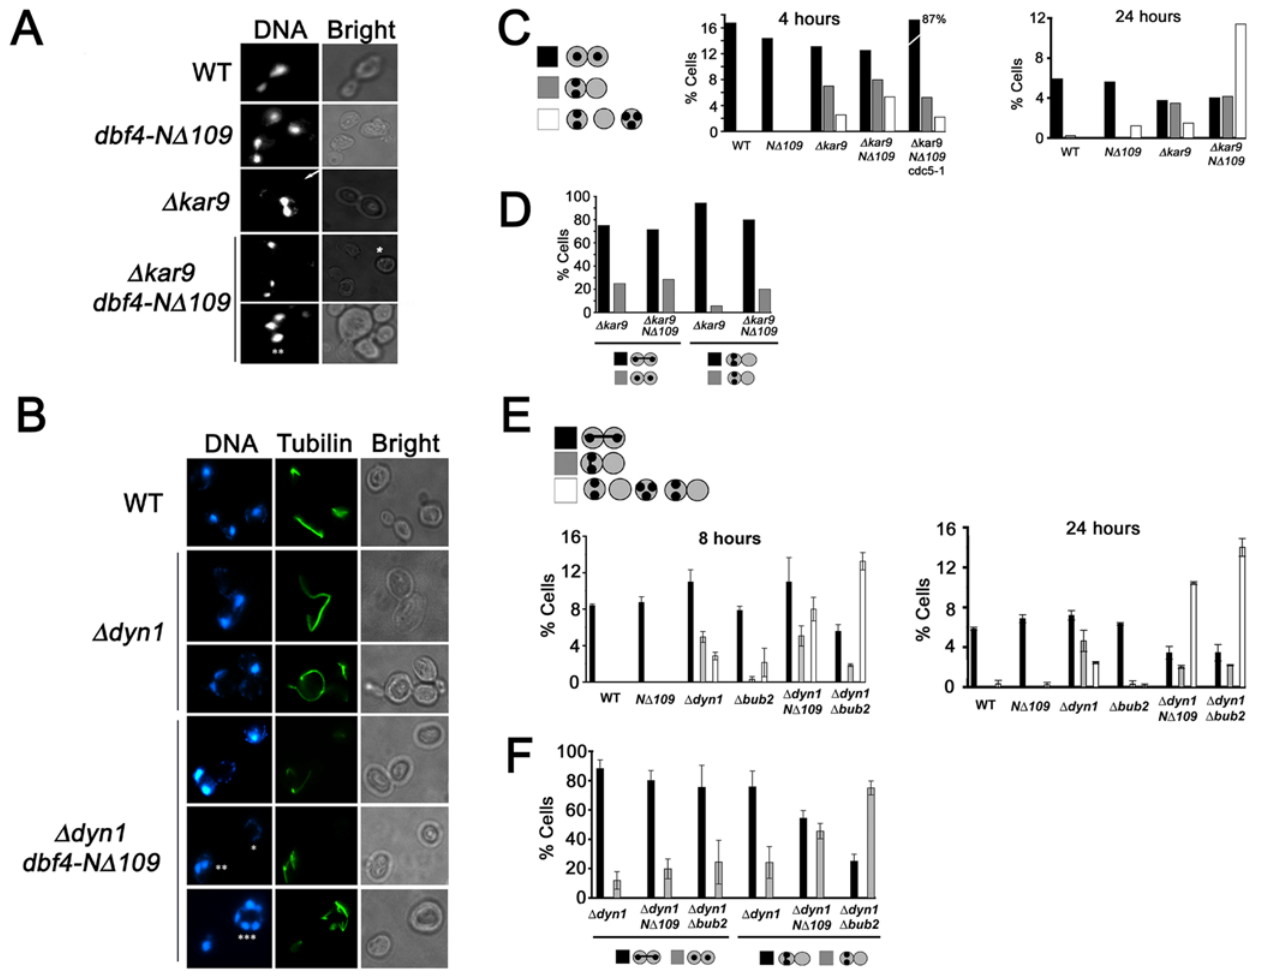
Figure 7. Deletion of the DBF4 PIR allows exit from mitosis in cells with misoriented nuclei. (A, B) Representative cells showing nuclear positioning and mitotic arrest defects. Nuclear position was analyzed after DAPI staining. Cells with anaphase spindles located exclusively in the mother cell body are noted (white arrow). Anucleate (*), binucleate (**) and multinucleate (***) cells were frequently observed in kar9 D dbf4-N D 109 (A) and dyn1 D dbf4-N D 109 (B) cells. (C, E) Quantitation of nuclear segregation defects. . 300 cells were counted for each strain and nuclear position was represented as a percentage of the total cells in culture. Black bars represent cells with nuclei segregated between mother and daughter cells; gray bars, divided nuclei in the mother cell; white bars, multinucleate and anucleate cells. (D, F) Spindle morphology of strains with misoriented nuclei and spindles. . 50 cells were counted for each genotype. Black bars represent cells with mitotic spindles. Gray bars represent cells that have exited